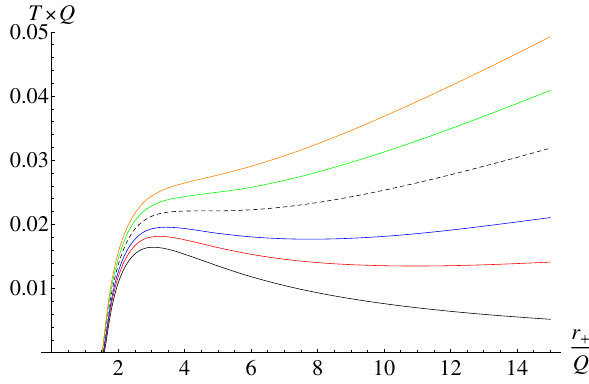
Fig. 5 We plot the reduced temperature of the black hole against the reduced horizon radius under the different values of the pressure. The orange, green, dashed black, blue, red, and black curves correspond to l / Q = 9, 10, ≈ 11.5637 ( l c / Q ), 15, 20,